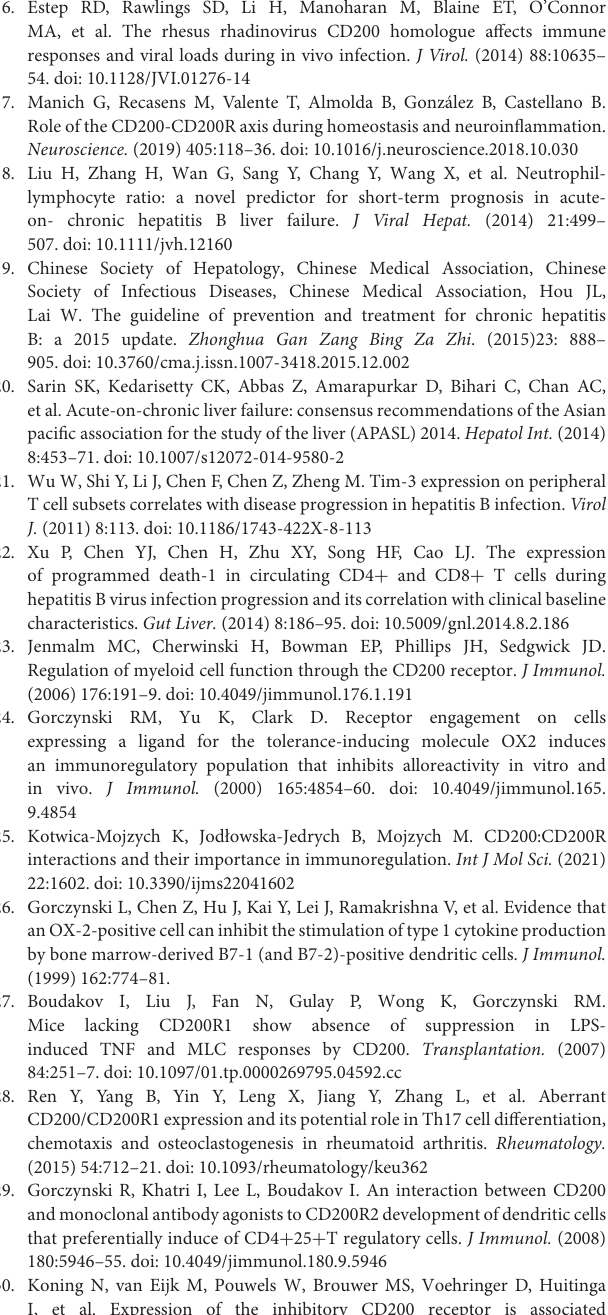
Supplementary Figure 1 | Analysis of prognostic factors in patients with ACLF. Comparison of T cell differentiation between survival and non-survival groups with ACLF. Mann–Whitney or unpaired t test was used to analyze statistical